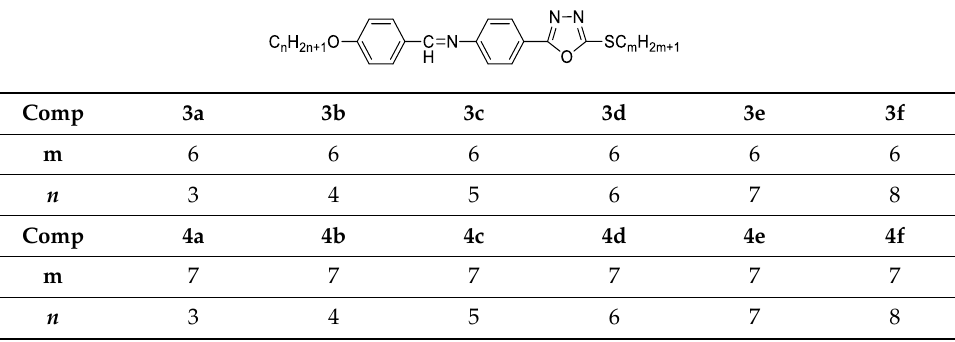
Figure 4. The optical photomicrograph of compound 2a , ( a ) temporary transition bars, ( b ) from smectic A to smectic B phase, and ( c ) plot of phase transition temperatures. Reprinted/adapted with